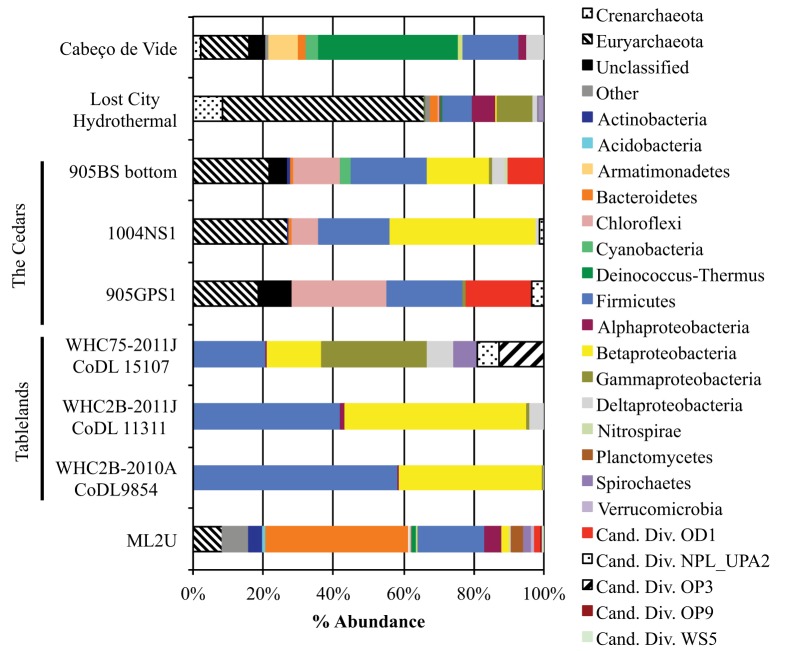
Comparison between phylotypes from the source at Manleluag (ML2U) and results from studies of other serpentinizing systems, separated by Phylum (and class, in the Phylum Proteobacteria). Examples include terrestrial serpentinizing seeps from Tablelands Ophiolite Complex in Newfoundland, Canada (Brazelton et al., 2013) and the Cedars in the Coast Range Ophiolites, USA (Suzuki et al., 2013). Also included are examples from 35-year old carbonates at Lost City Hydrothermal Field (Brazelton et al., 2010) and a subterranean serpentinizing aquifer, Cabeço de Vide, in Portugal (Tiago and Veríssimo, 2013).